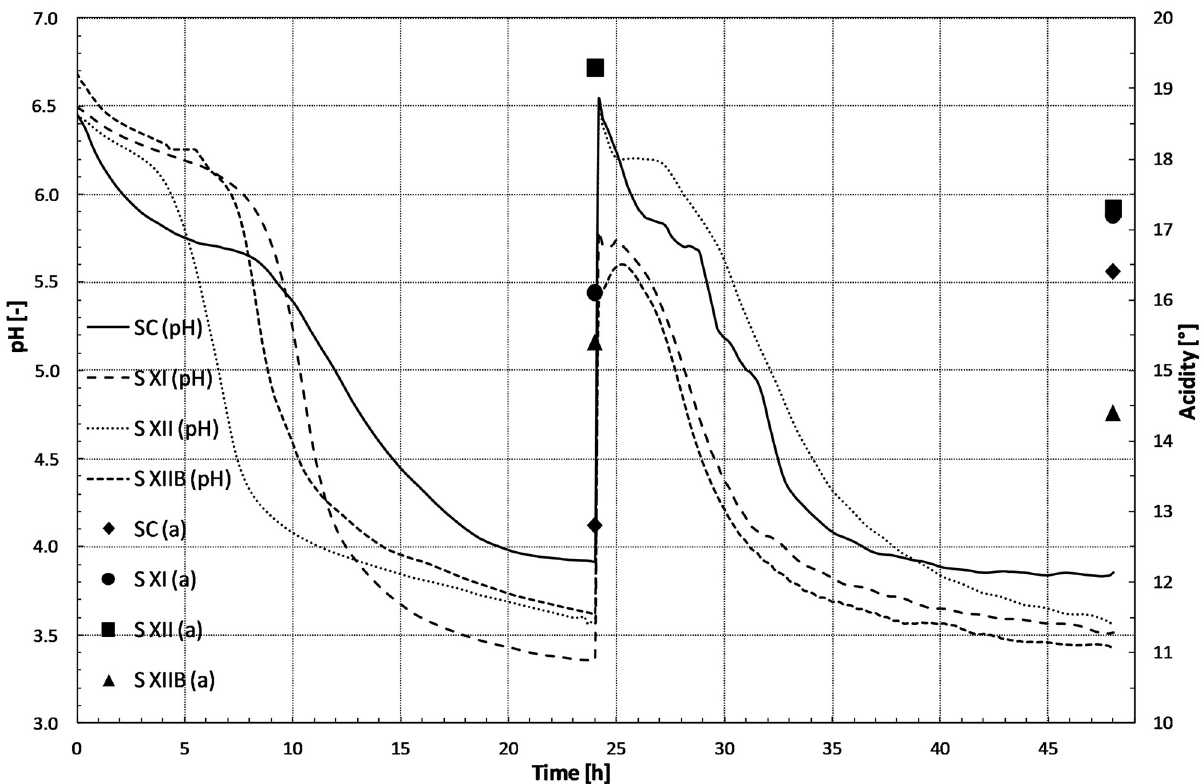
Fig 1. Active and potential acidity changes during sourdough fermentation. Active acidity (pH) and potential acidity (a).